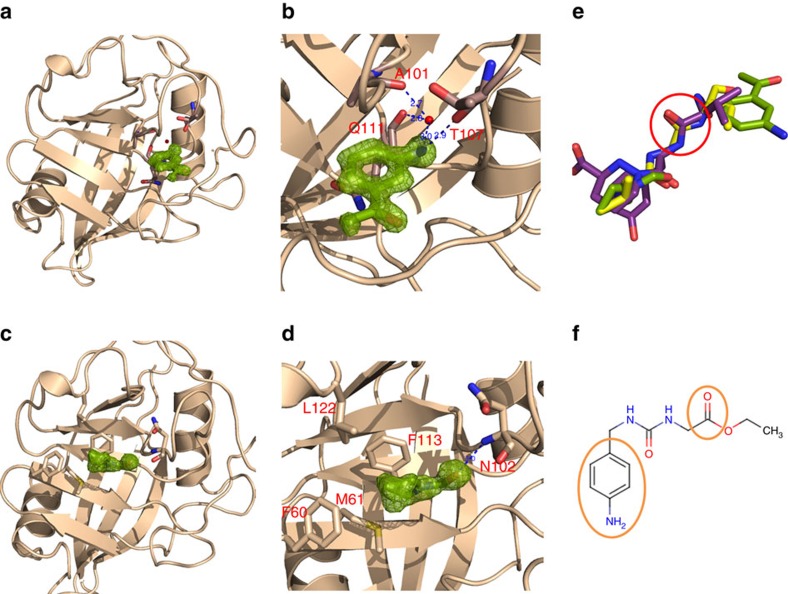
Cocrystal structures of fragment hits with CypD and linking strategy.(a,b) The crystal structure shows fragment 6 bound to the gatekeeper pocket, predominantly through a hydrogen bond with Thr107. The green mesh and surface represent the electron density map of fragment 6 (2Fo–Fc omit map contoured at 1.0σ). The gatekeeper pocket is zoomed in b. (c,d) The crystal structure shows fragment 13 bound to the catalytic site, predominantly through a hydrogen bond with Asn102. The green mesh and surface represent the electron density map of fragment 13 (2Fo–Fc omit map contoured at 1.0σ). The catalytic site of CypD is zoomed in d. (e) Superimposition of PDB 1CWA (CypA-CsA) and 1YND (CypA-SfA) with cocrystals CypD-fragment 6 and CypD-fragment 13. CsA is represented with yellow sticks. SfA is represented by purple sticks. Fragments 6 and 13 are represented by green sticks. The red circle shows the urea moiety used to link fragments 6 and 13. (f) Chemical structure of compound 22, generated by linking fragments 6 and 13 with a urea moiety. The orange circle shows key atoms from fragments 6 and 13.